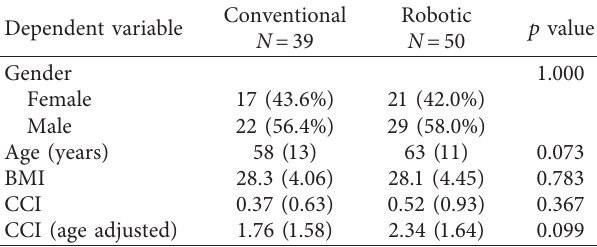
Table 1: Summary of cohort